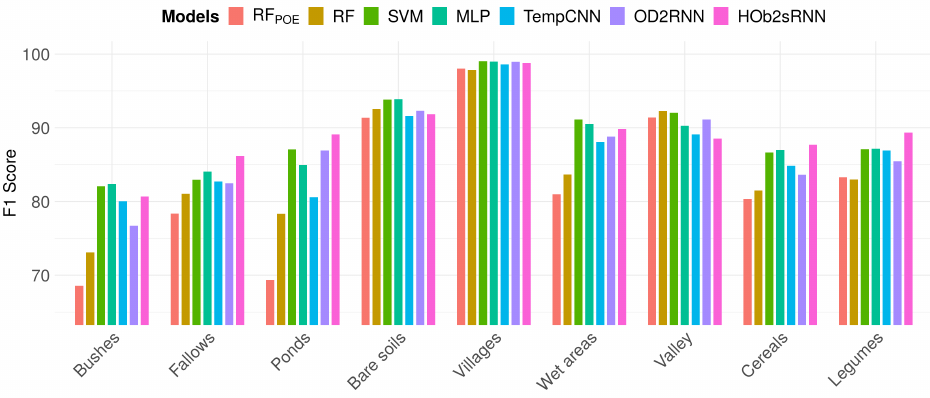
Figure 10. Per-Class F1 score for the Senegalese site (average over ten random splits).